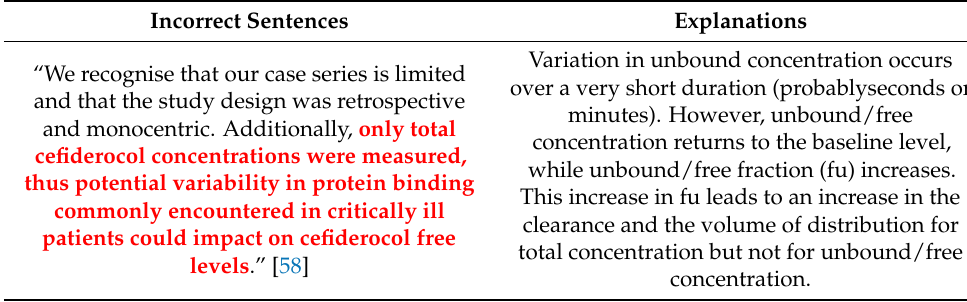
Table 3. Examples of incorrect explanations found in the literature. Incorrect